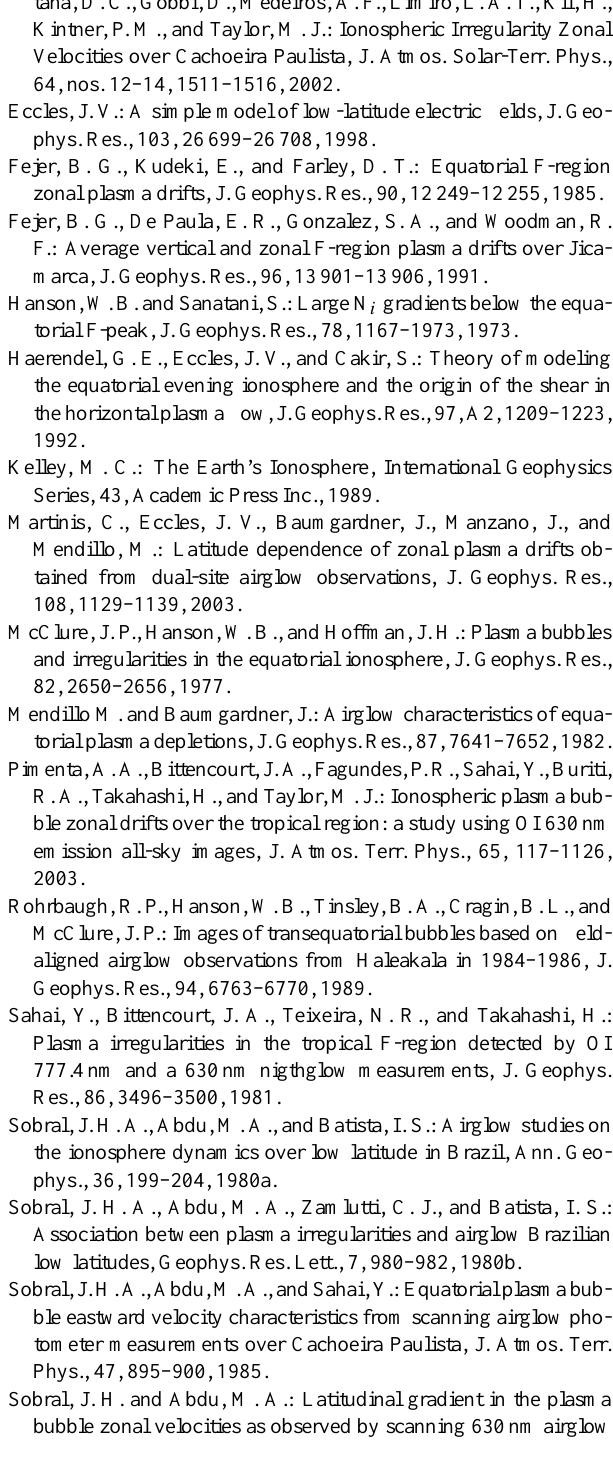
Fig. 4 the mean zonal drift velocities varies from 95.3 ms − 1 at F10.7=100 (x10 − 22 Wm 2 Hz − 1 ) to 116.6 ms − 1 at 250 (x10 − 22 Wm 2 Hz − 1 )